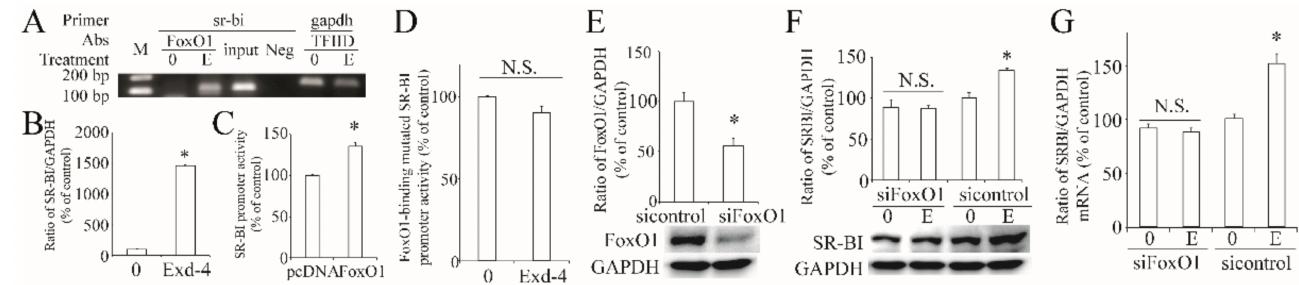
Figure 5. Roles of FoxO1 in exendin-4-regulated hSR-BI/CLA-1 transcription. ( A ) Binding of FoxO1 to the hSR-BI/CLA-1 promoter in HUVECs treated with or without exendin-4. FoxO1 antibody specifically immunoprecipitates hSR-BI/CLA-1chromatin from HUVECs by ChIP assay. No ChIP was detected when the chromatin was immunoprecipitated with unspecific negative control IgGs (Neg). Input was a positive control. ( B ) The qPCR result with the template from ChIP. ( C ) The effect of FoxO1 on hSR-BI/CLA-1 promoter activity. ( D ) The effect of exendin-4 on the promoter activity of FoxO1-binding site-mutated hSR-BI/CLA-1 promoter by altering two base pairs